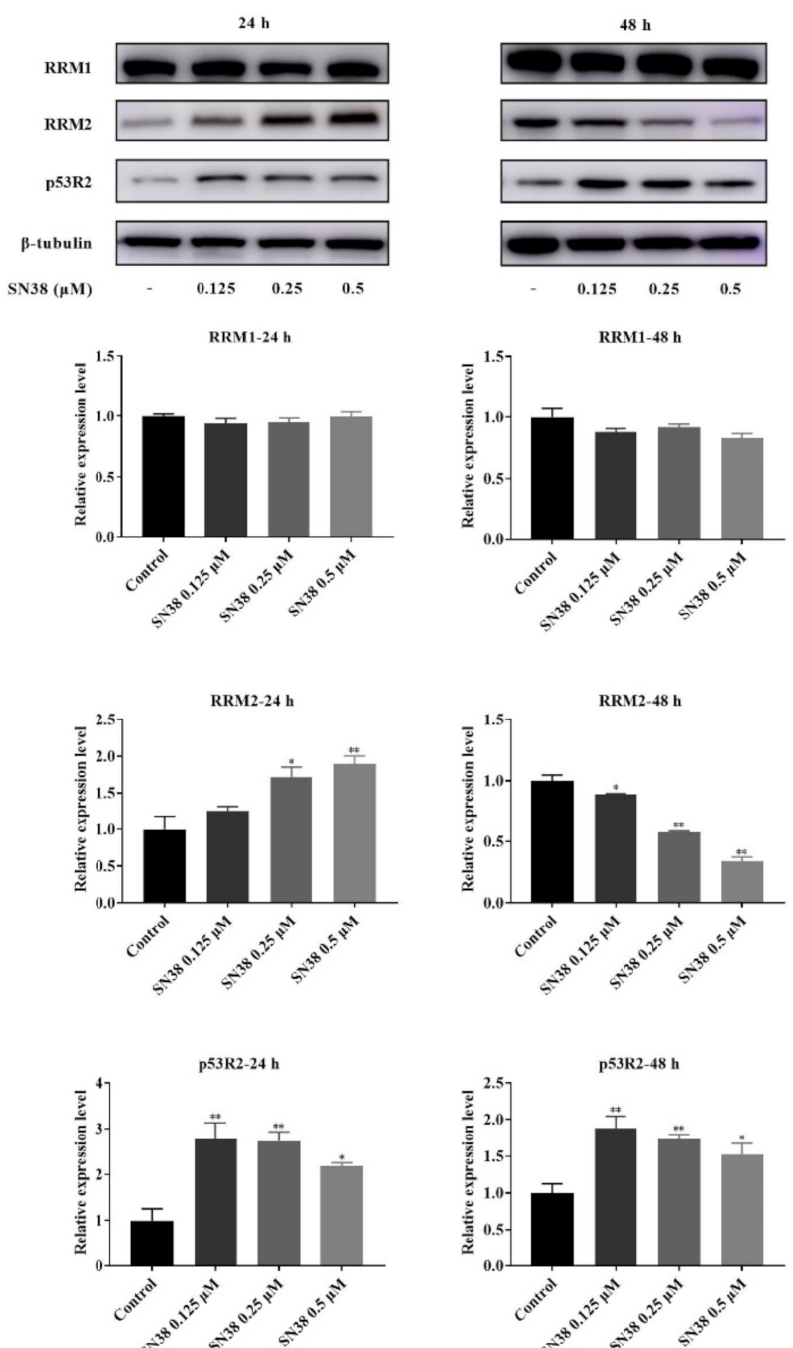
Figure 4. RRM1, RRM2, and p53R2 expression of HCT 116 cells after being treated with SN38. Note: * p < 0.05, ** p < 0.01, compared with control